Question: Give a one-sentence summary of this figure.
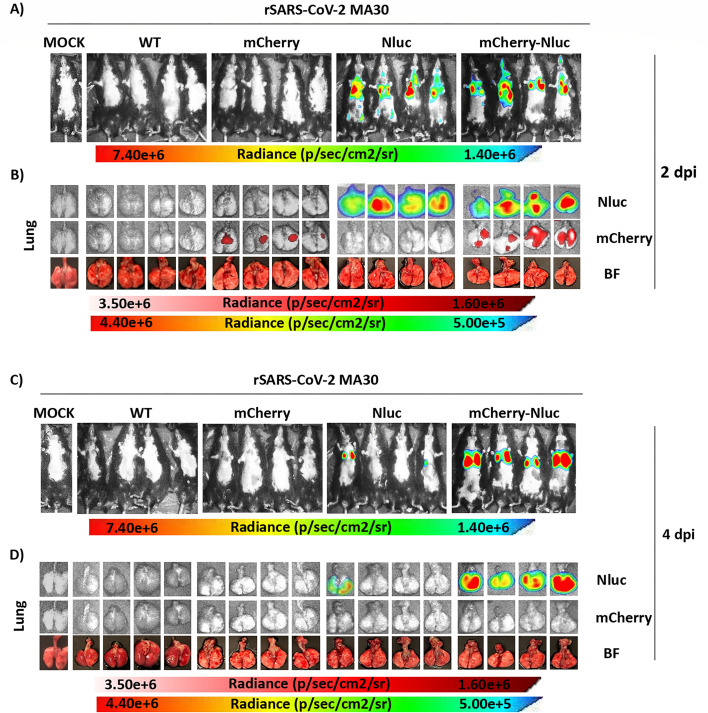
Answer: In vivo and ex vivo kinetics of reporter-expressing rSARS-CoV-2 MA30 in C57BL/6 mice. ( A and C ) Nluc activity in whole 22-week-old C57BL/6 mice mock-infected or infected i.n. with 10 5 PFU/mouse with rSARS-CoV-2 MA30 WT, rSARS-CoV-2 MA30 mCherry, rSARS-CoV-2 MA30 Nluc, and rSARS-CoV-2 MA30 mCherry-Nluc at 2 ( n = 4 mice/group) and 4 ( n = 4 mice/group) dpi using the Ami HT IVIS. ( B and D ) Excised lungs from mock-infected or infected mice from panels A and C were monitored for Nluc and mCherry expression at 2 and 4 dpi. Bright field (BF) images of the lungs were also collected at the same time points. Scale bars in ex vivo lung images = 5 mm.